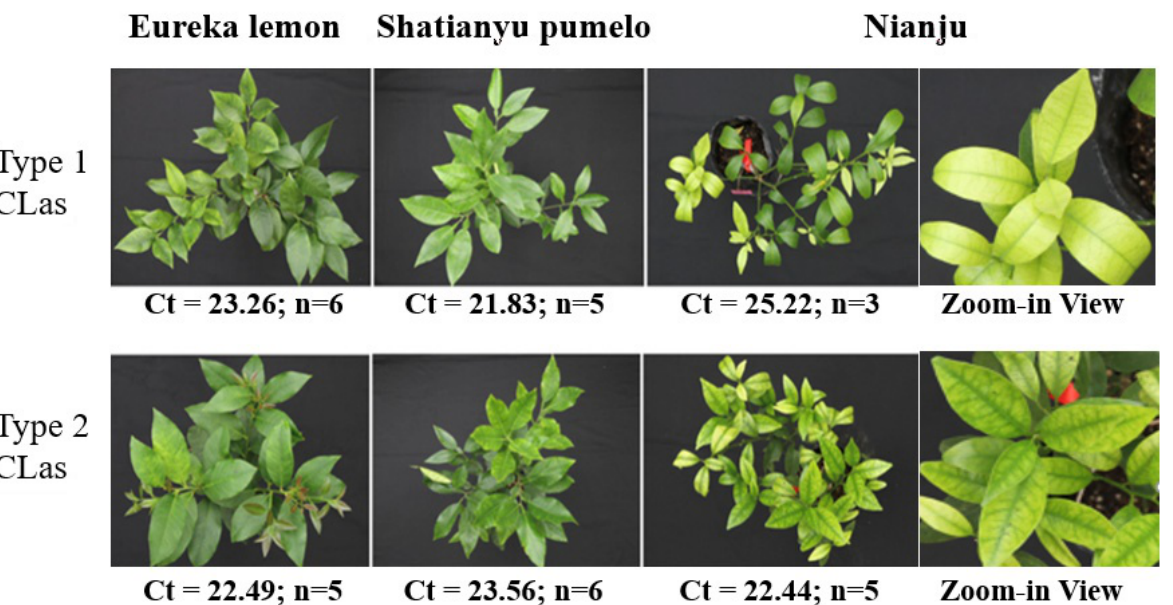
Figure 3. Representative symptoms of three citrus cultivars (Eureka lemon ( Citrus limonia Osbeck), Shatianyu pumelo ( C. maxima (Burm.) Merr.), and Nianju ( C. reticulata Blanco)) six months after inoculation with “ Candidatus Liberibacter asiaticus” (CLas) strains carrying Type 1 phage (Type 1 CLas) and Type 2 phage (Type 2 CLas). Ct values were based on primer set CLas4G/HLBr (17); letter n represents number of replications. Ct values were means of all replicates.